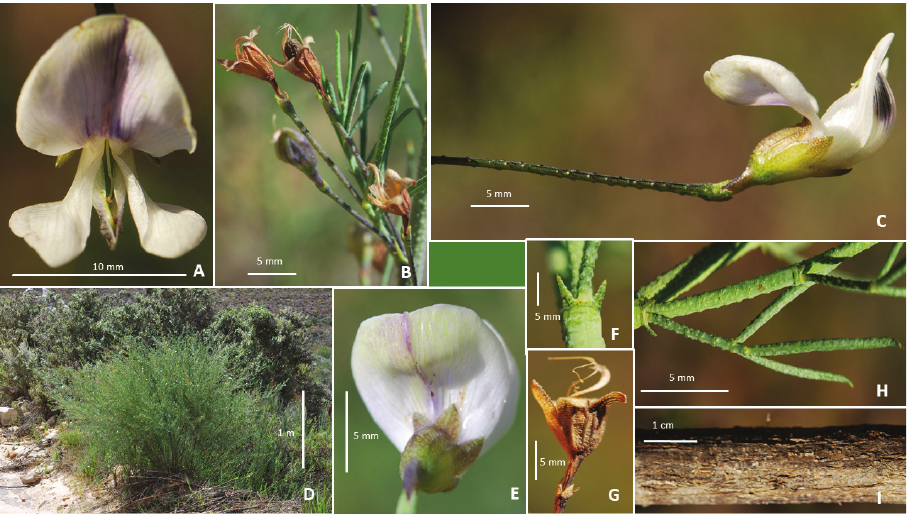
Figure 1. Psoralea forbesiae C.H.Stirt., A.Bello & Muasya: A front view of flower B Fruiting calyces C Side view of flower D Habit E Back of standard F Stipule G Fruiting calyx H Leaf I Stem. Photographs by Charles Stirton and Abubakar Bello. Voucher Stirton & Muasya 13279